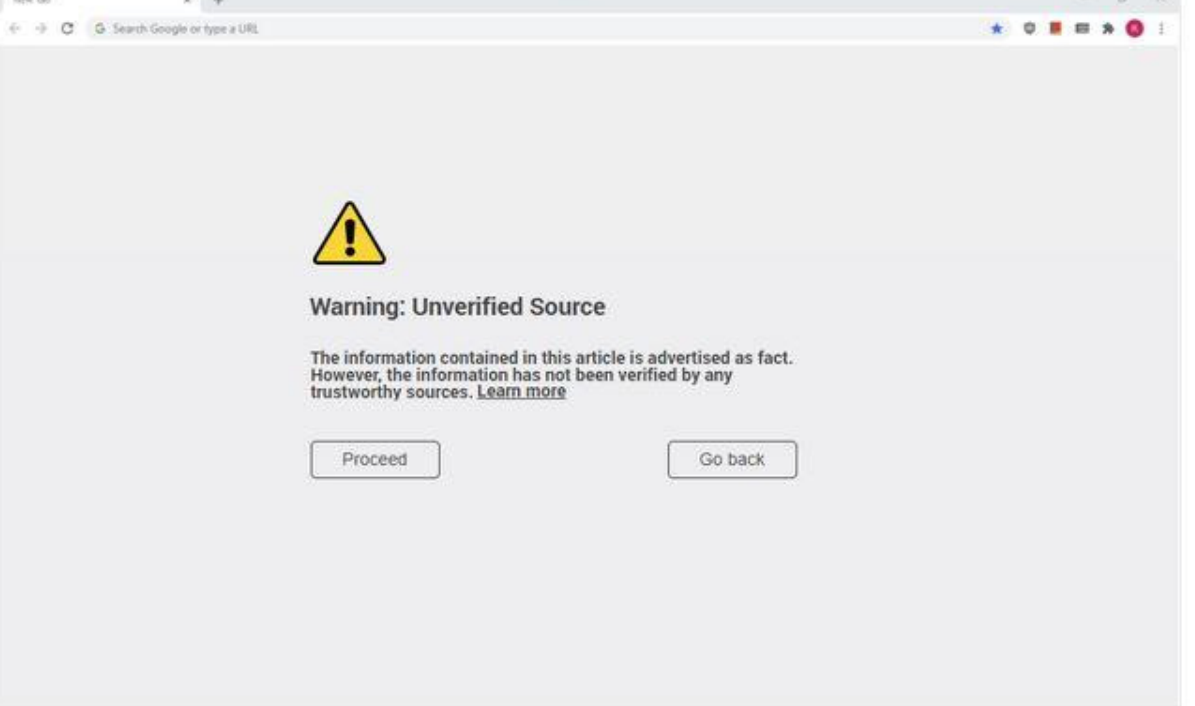
Figure 38. Blocking warning label [76].